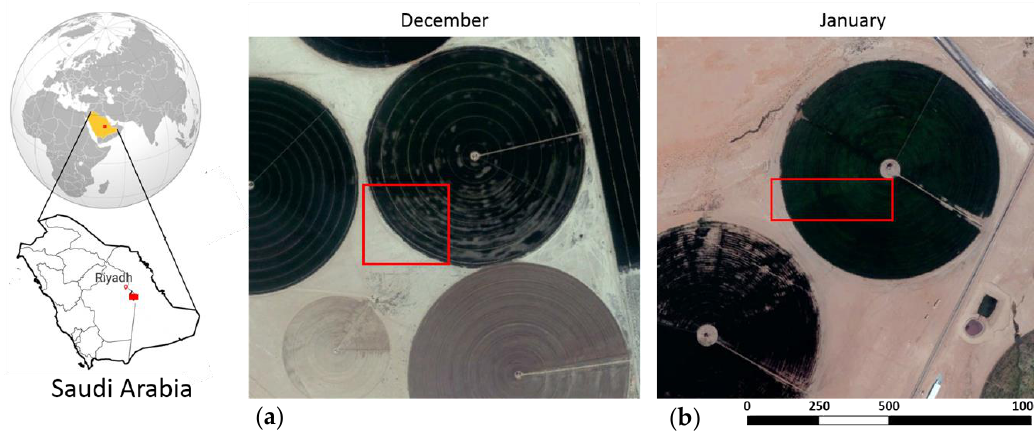
Figure 1. The Tawdeehiya farm and the two focus areas where unmanned aerial vehicle (UAV) surveys were conducted on 13 December 2016 ( a ) and 31 January 2017 ( b ).